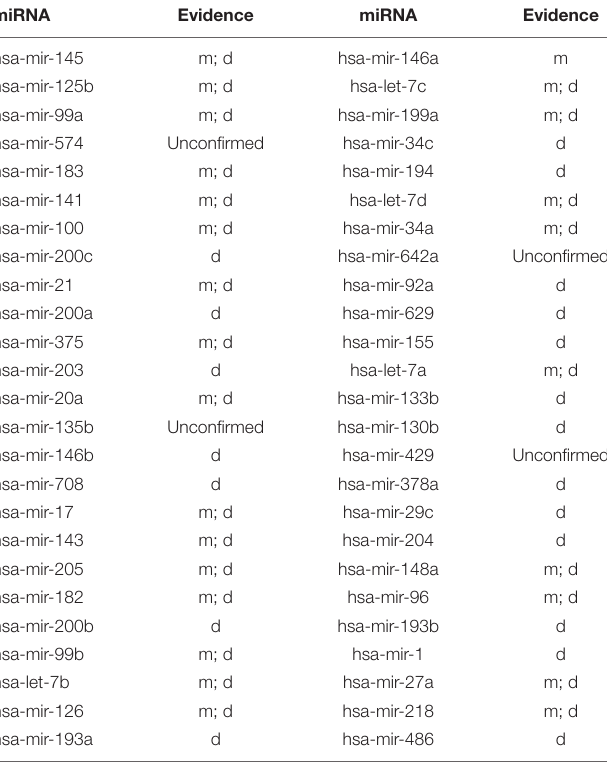
TABLE 4 | The top 50 potential miRNAs associated with breast neoplasms. miRNA Evidence miRNA